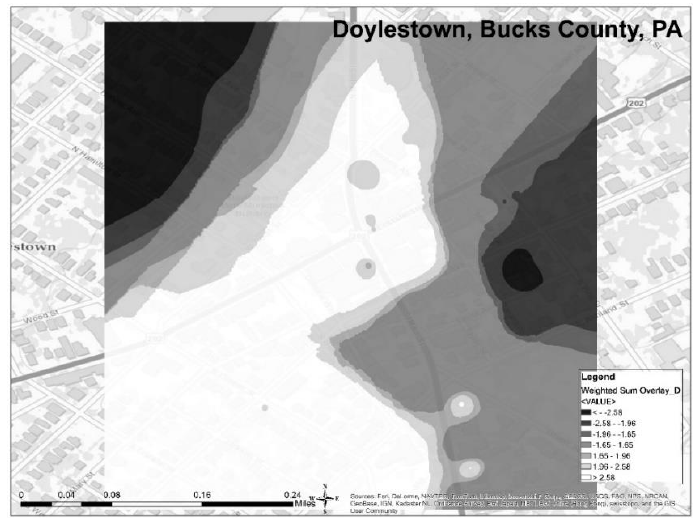
Figure 2. Doylestown Hot Spot Analysis.